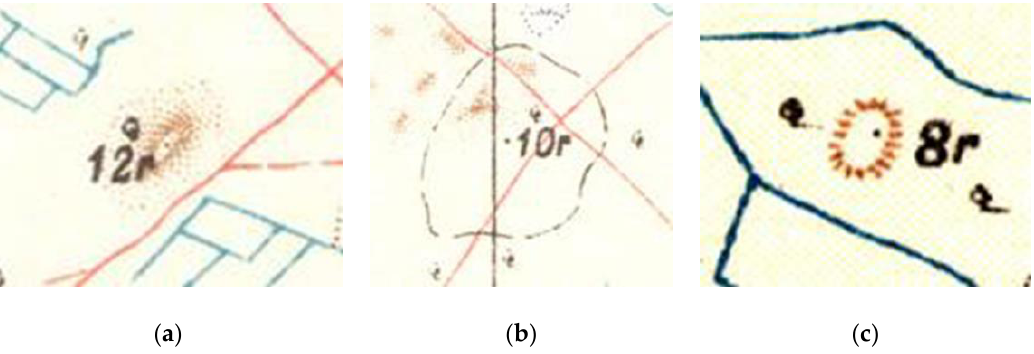
Figure 8. ( a ) Shaded; ( b ) Form-line; ( c ) Hachure mound features (Images courtesy of Cambridge University Library).